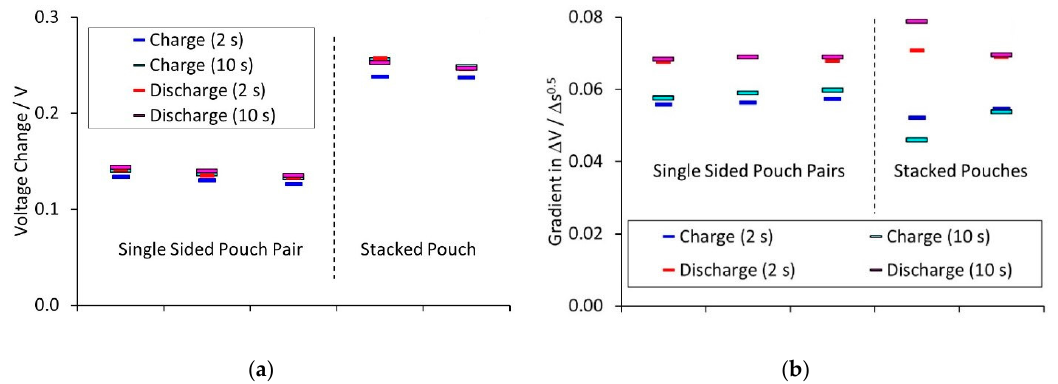
Figure 7. Analysis of 20 C charge and discharge pulses with ( a ) initial voltage drop and ( b ) gradient during transit.